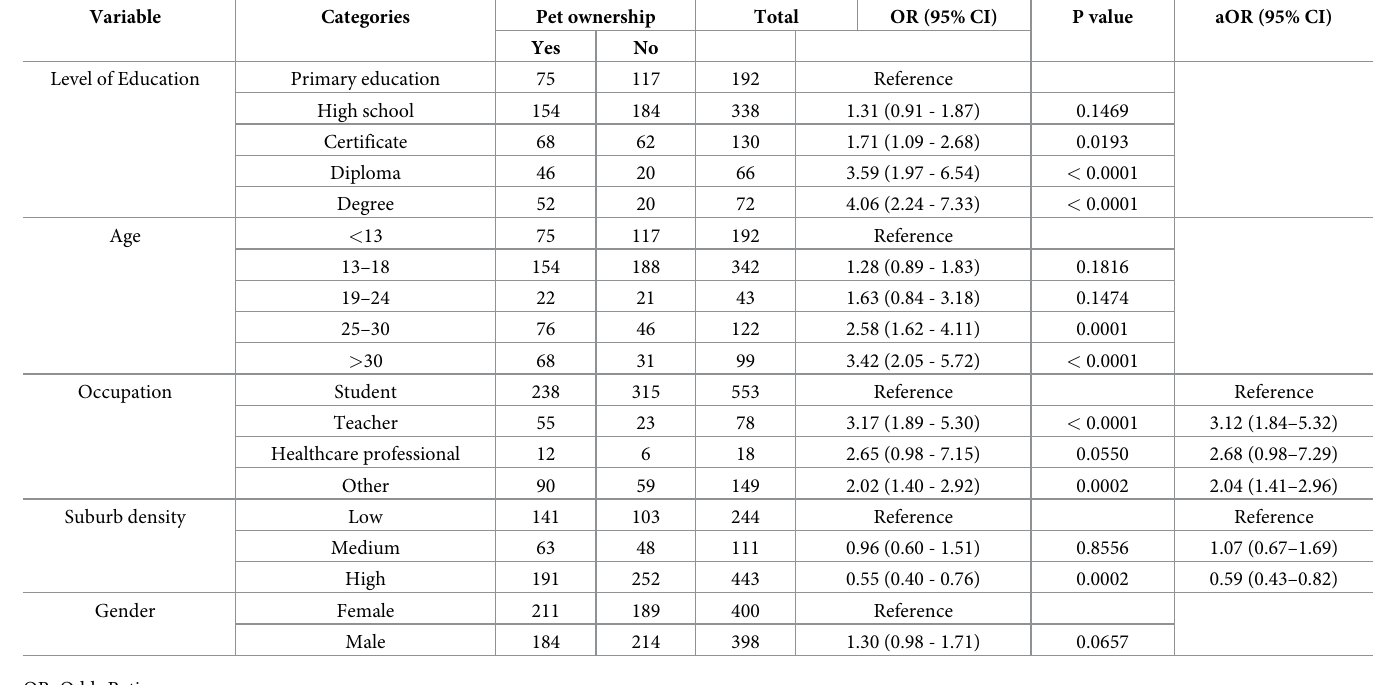
Table 4. Univariate and multivariable logistic regression analysis of the association between the socio-demographic variables and “owning a pet”.